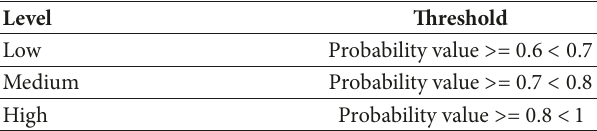
Table 1: Threshold level